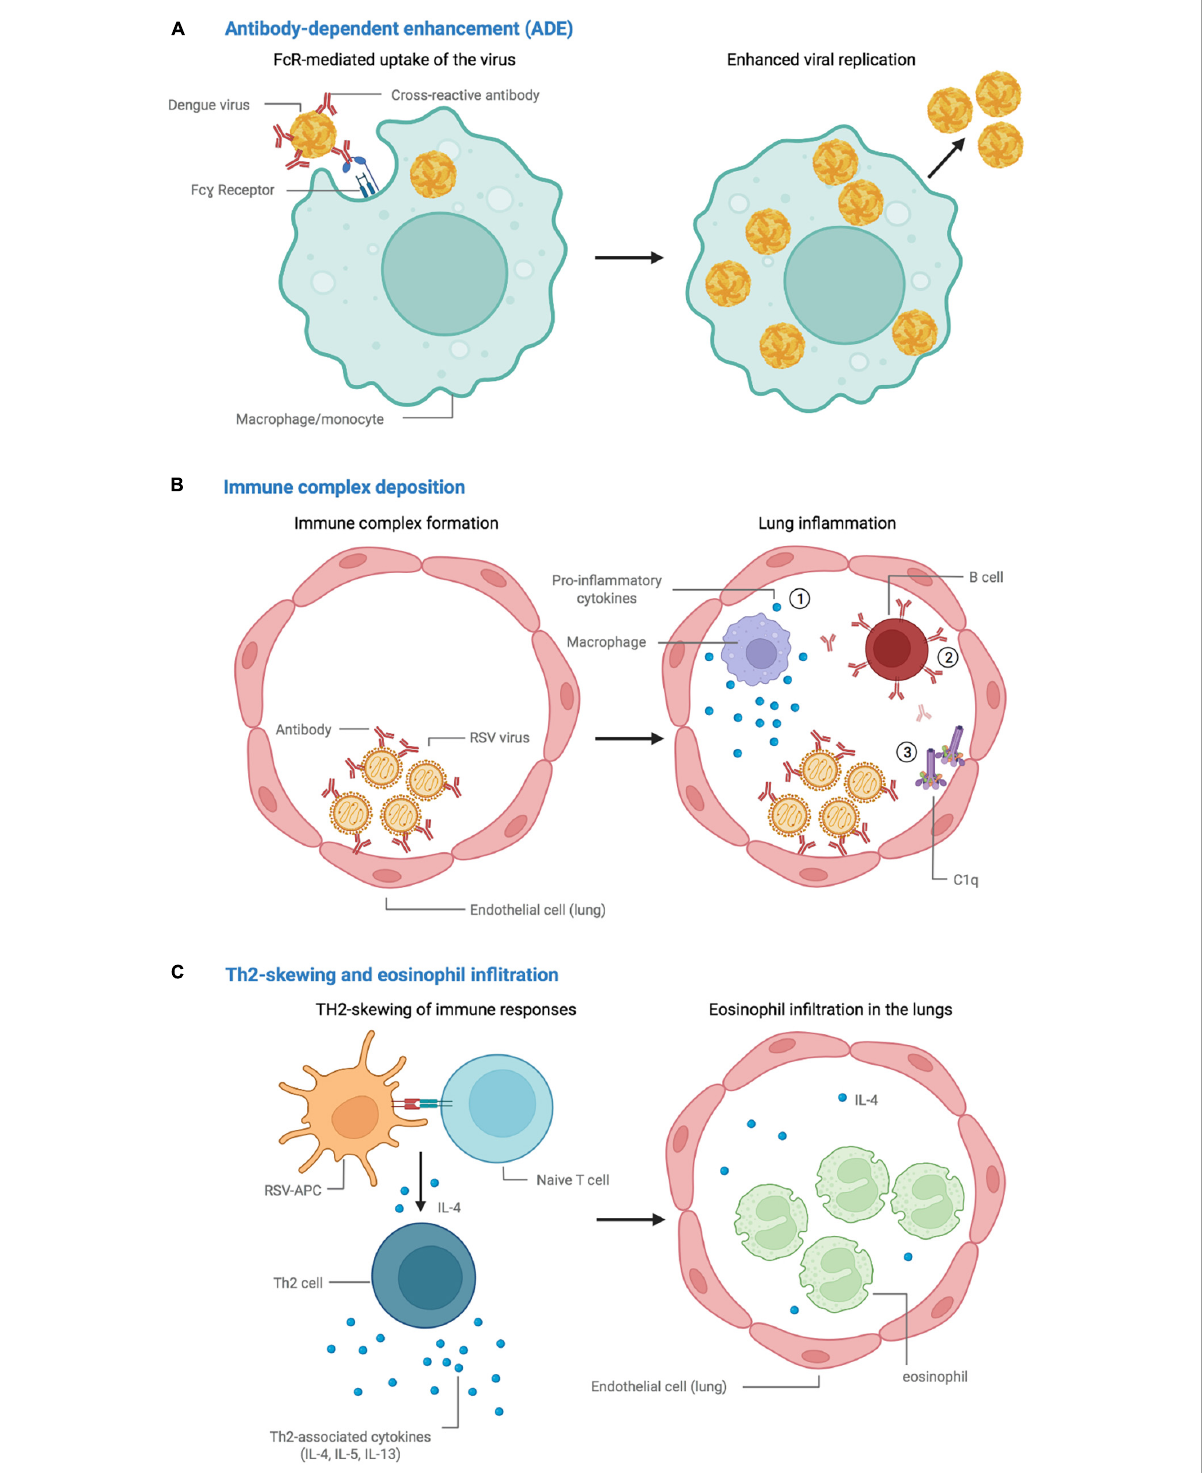
FIGURE1 Proposed mechanisms leading to vaccine-associated enhancement of disease. (A) Antibody-dependent enhancement (ADE), in which cross-reactive vaccine-elicited antibodies fail to neutralize the dengue virus and instead promote viral replication in FcR-bearing cells. (B) Immune complex accumulation and deposition in the lungs, promote (1) an inflammatory environment, (2) the production of antibodies, and (3) activation of the complement cascade. (C) Skewing of the immune response toward a Th2 phenotype, followed by eosinophil infiltration and accumulation in the lungs. Created with BioRender.com